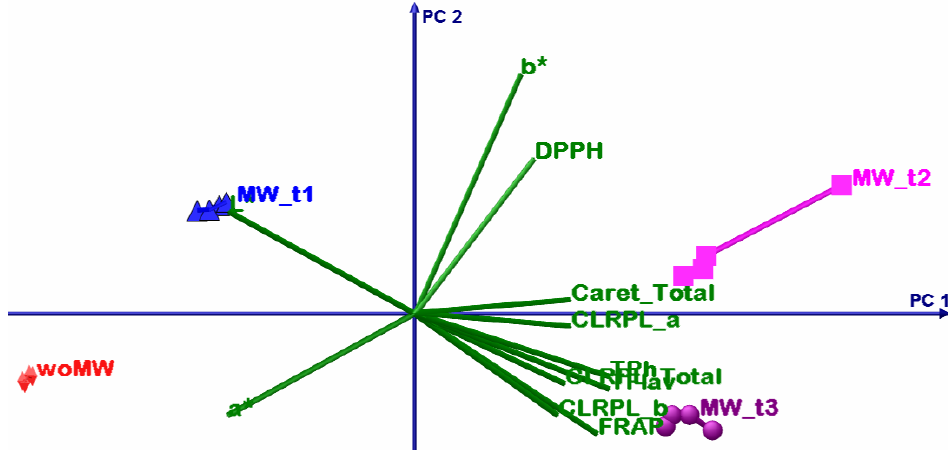
Figure 6. PCA biplot with PC1 (81.04%) and PC2 (15.59%) principal axes.